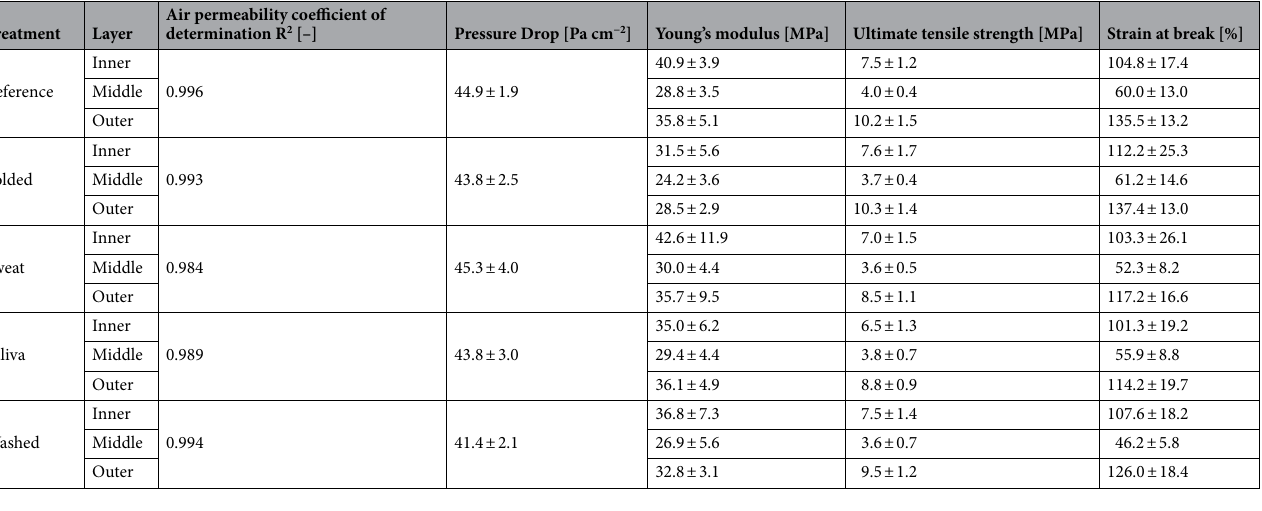
Table 2. For each type of treatment, list of the coefficient of determination R 2 of the permeability fitted curves in Fig. 2a along with the derived Pressure drop for an airflow of 8 L min −1 . In the last three columns, details of the derived mechanical properties for each treatment and layer: Young’s modulus, ultimate tensile strength and strain at break (also presented in Fig.